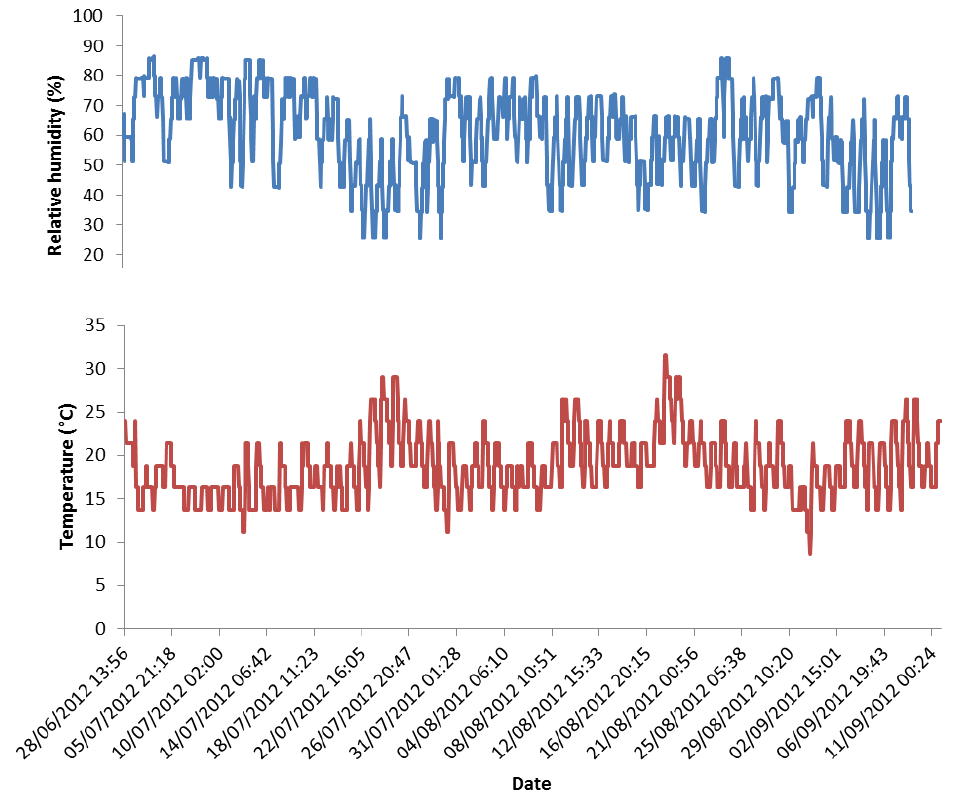
Figure 4. Outdoor hourly T and RH data from Apsley House from the end of June to early September